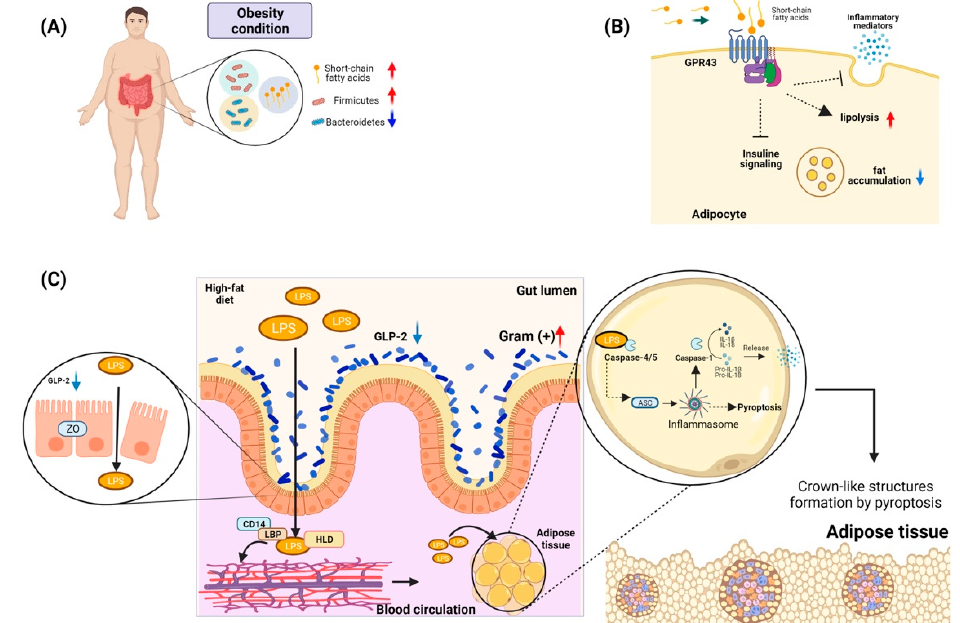
Figure 3. Gut microbiota and its role in obesity . ( A ) Phylum of bacteria related to the development of obesity in individuals. Under conditions of obesity, bacteria belonging to the phylum Firmicutes are increased, while Bacteroidetes are decreased. These bacteria have been related to the presence of short-chain fatty acids. ( B ) Some G protein-coupled receptors abundant in adipocytes, such as GPR43, may play a role in the modulation of the immune response. Activation of GPR43 can promote lipolysis and decrease fatty acid accumulation. ( C ) Antigens from the bacterial microbiota of the gut in conditions of obesity, such as LPS, can cross the epithelial barrier of the gut due to the rupture of tight junctions such as zona occludens (ZO), which is related to the decrease in the expression of GLP-2. This LPS can travel through the circulation by forming a complex of HLD plus LBP and CD14. This complex gives it hydrosoluble characteristics, allowing it to reach the adipose tissue to be absorbed by adipocytes. Once inside the adipocyte, it is recognized by Caspases 4/5, which trigger the activation of the inflammasome. Then, it could activate either the maturation of proinflammatory molecules such as IL-1B and IL-18 or activate pyroptosis. The pyroptosis present in the adipose tissue can trigger the formation of crown-like structures, which are composed of immune system cells such as macrophages and adipose tissue cells and cells in pyroptosis. These structures have been described as an essential element in insulin resistance and in the development of chronic inflammation in obese